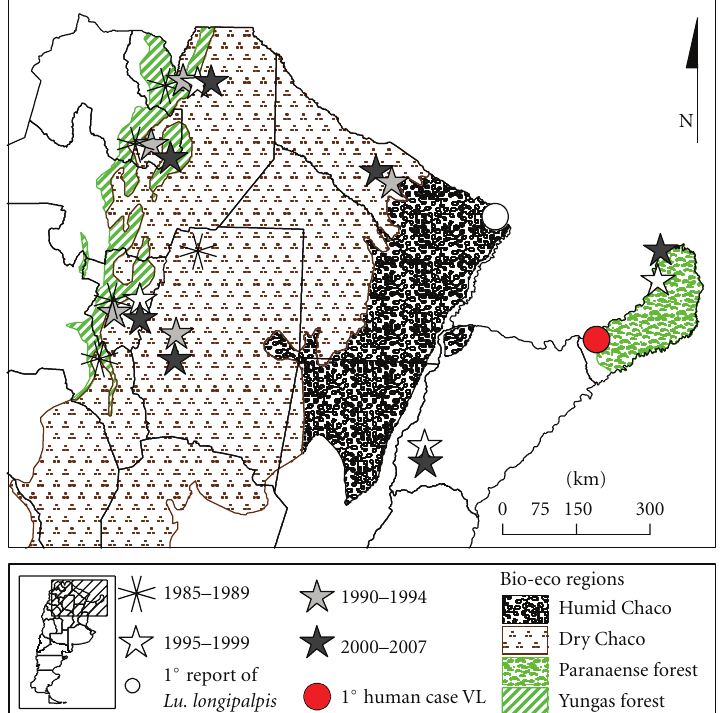
Figure 1: Leishmaniasis in Argentina by bio-eco regions. Distribution of outbreaks by site and